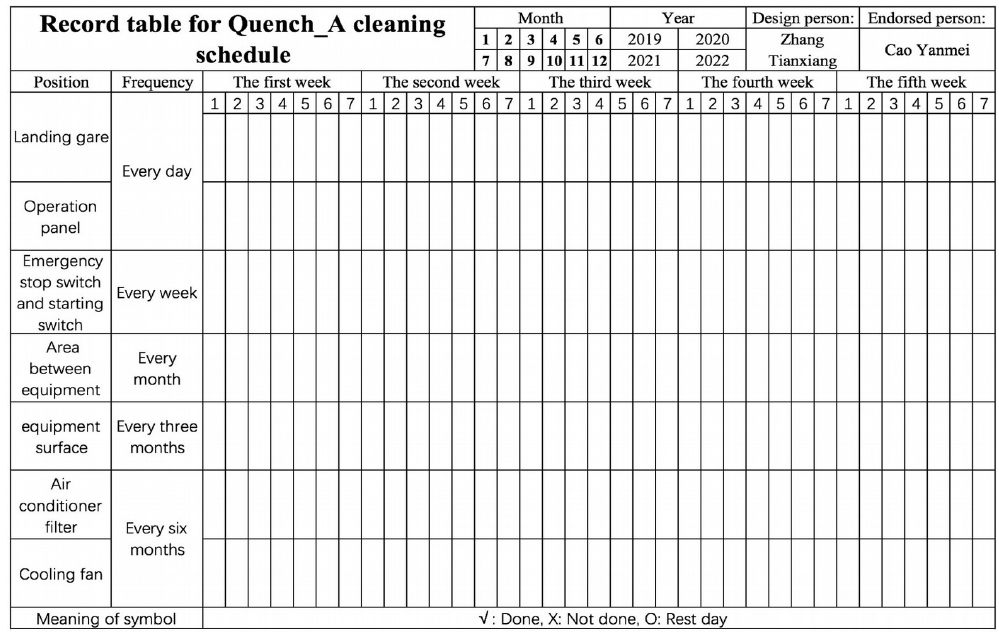
Figure 10. The record for Quench_A cleaning schedule (The actual display is in